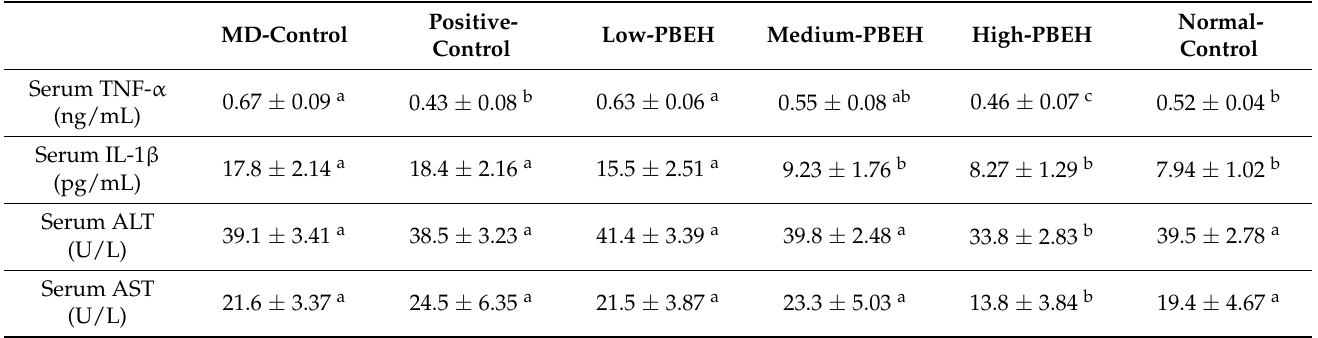
Table 3. Proinflammatory cytokines and liver damage index in the circulation. MD-Control